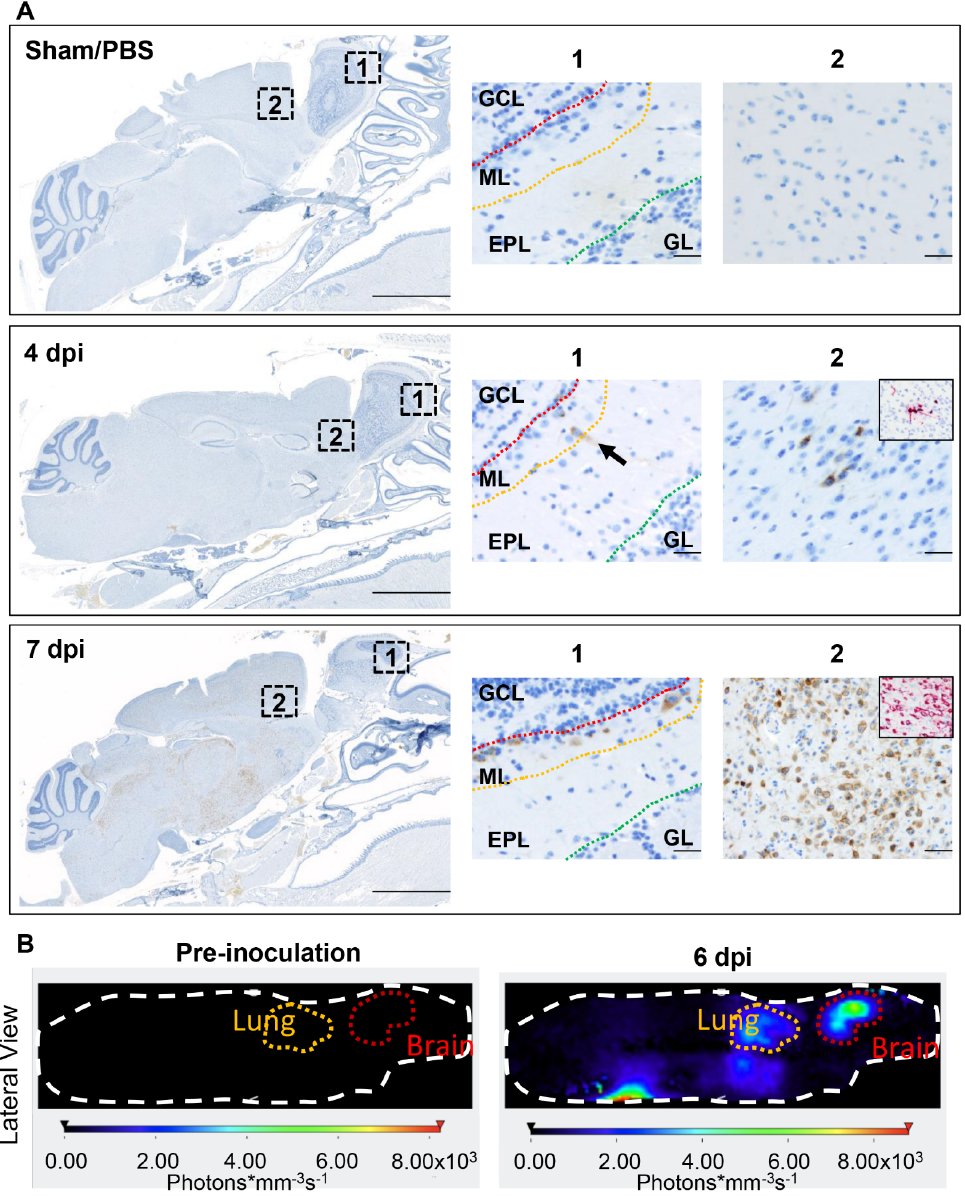
Figure 6. Invasion of SARS-CoV-2 into the central nervous system. ( A ) Sagittal sections of the head of non-infected (Sham/PBS, top panel) and infected (4 and 7 dpi, middle and bottom panel, respectively) were analyzed for viral protein and RNA distribution. At 4 dpi (middle panel), SARS-CoV-2